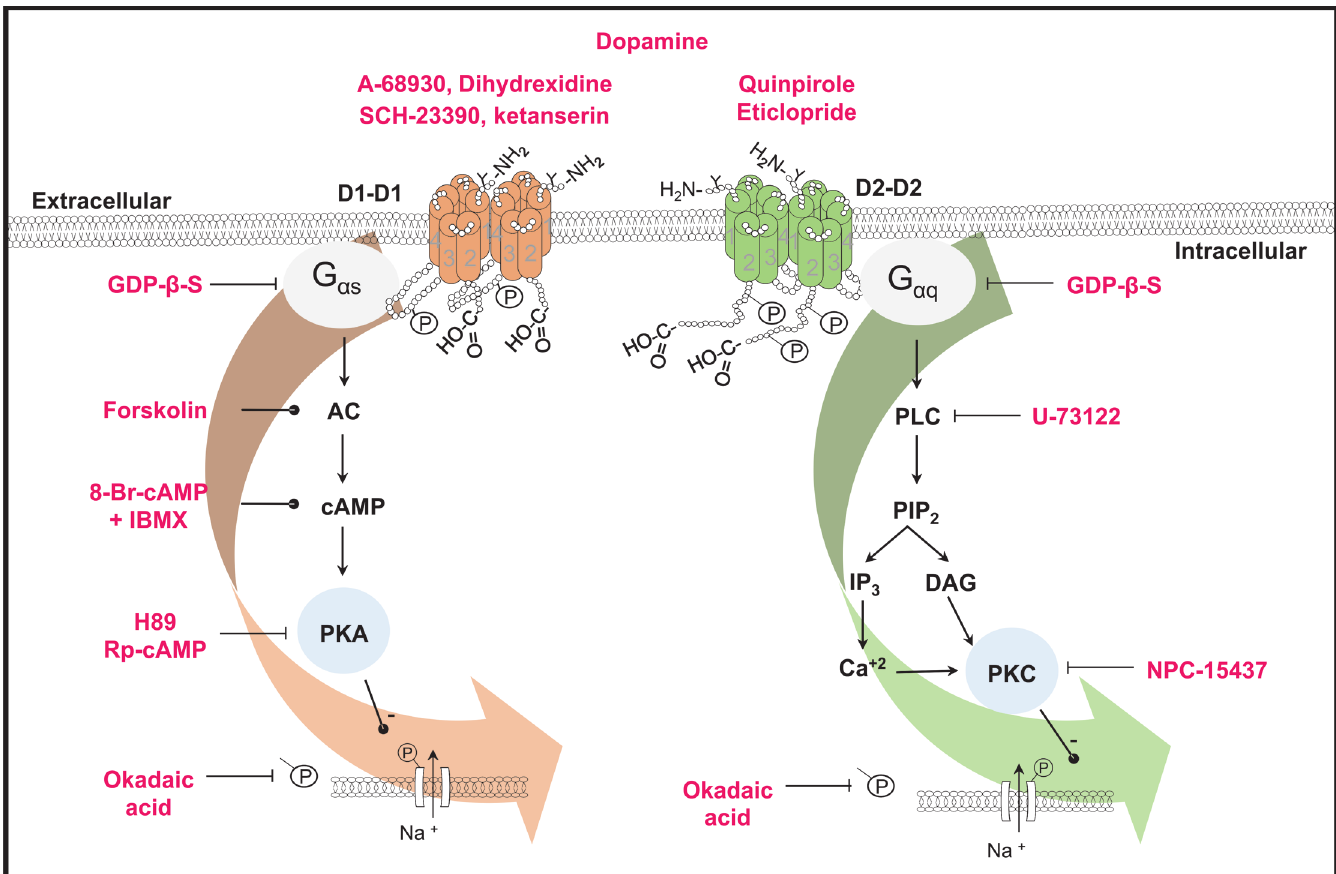
Fig 8. Scheme of the signaling pathways activated by D1- and D2-like receptors in the spiral ganglion neurons. Receptors are shown as homodimers. Phosphorylation and glycosylation sites are indicated (P and Y). The drugs used in this work are shown in red. Lines with transverse-endings indicate blockade and those with circle-endings stimulation. D1-like receptors are coupled to a G α s protein leading to AC stimulation, thus increasing cAMP levels and subsequent PKA activation. PKA phosphorylates the Na + channels thus decreasing the I Na . D2-like receptors are coupled to a G α q protein whose activation stimulates the PLC, which cleaves PIP 2 into IP 3 and DAG, the IP 3 increases the Ca 2+ concentration, and both Ca 2+ and DAG activates PKC leading also to a Na + channel phosphorylation thus decreasing the I Na . In both cases, phosphorylation was prevented by okadaic